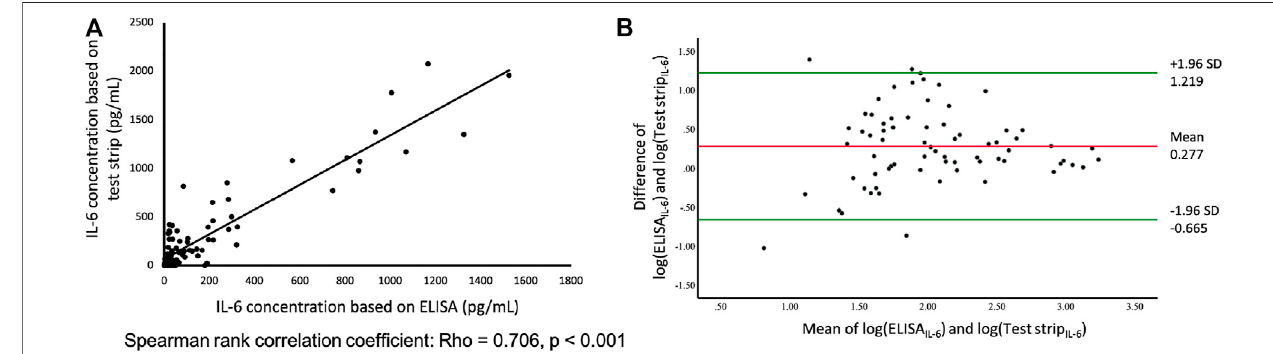
FIGURE2|(A) Comparison ofpaper-basedteststripandELISAforIL-6assaysusingserumfrompatients,includingin fl uenza,enterovirus,Mycoplasma,dengue, n (cid:1) 83. Y -axis; IL-6 concentration measured by test strip. X -axis; IL-6 concentration measured by ELISA. (B) Bland and Altman plot of log-transformed data. The differences between theIL-6basedon teststrip and ELISA(log transformation) inrelation tothe meanofthetwomeasurements(logtransformation), n (cid:1) 83.Greenlines indicate the limits of agreement ( ± 1.96 SD).